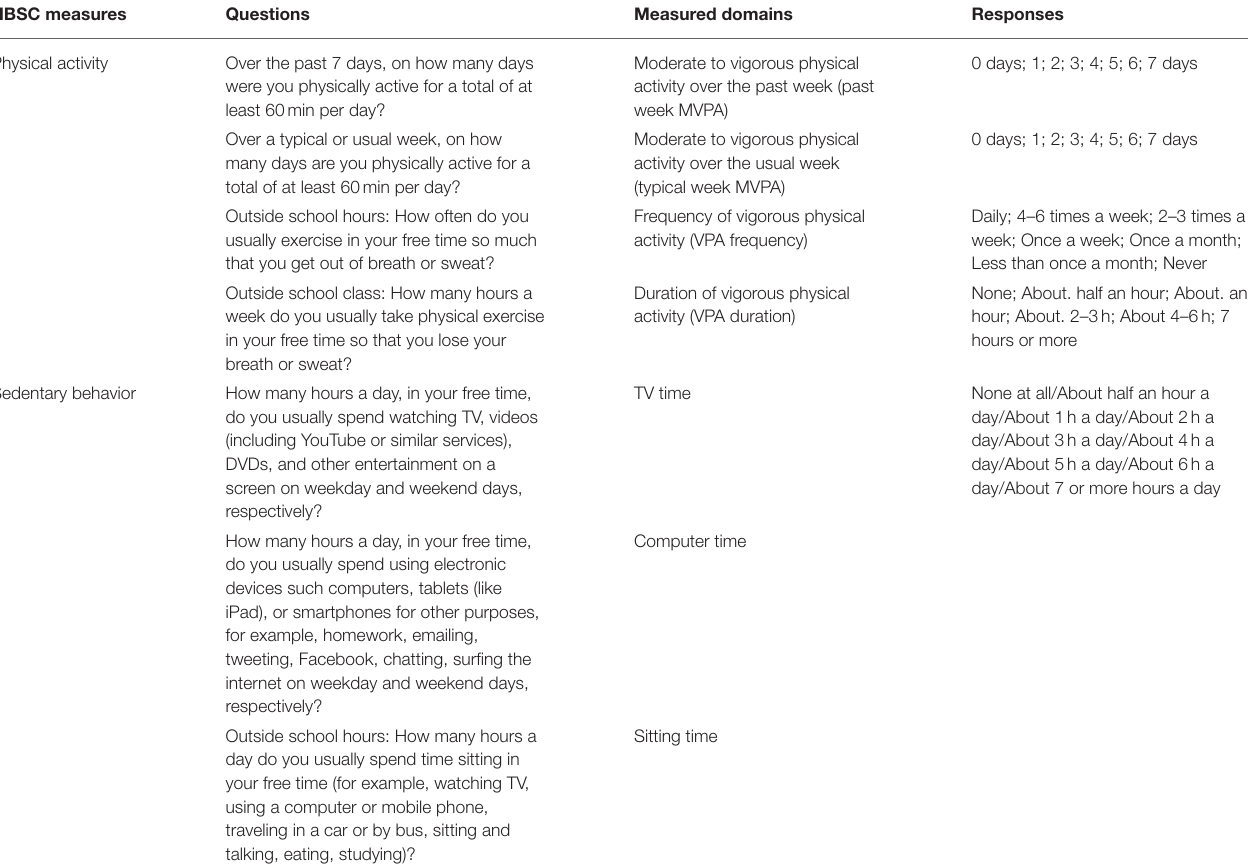
TABLE 1 | Specific questions and their responses of each included study used as physical activity and sedentary behavior in this